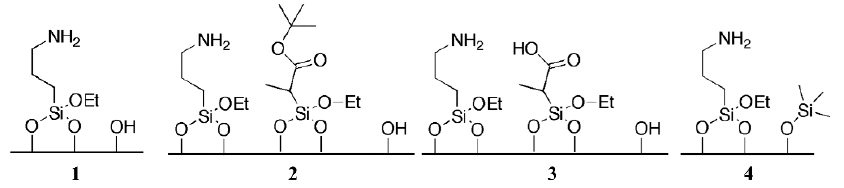
Figure 17. Hybrid bi-functional catalysts tested in the reaction of 4-nitrobenzaldehyde with ace- tone [101]. Reprinted with permission from [101]. Copyright 2012, American Chemical Society.